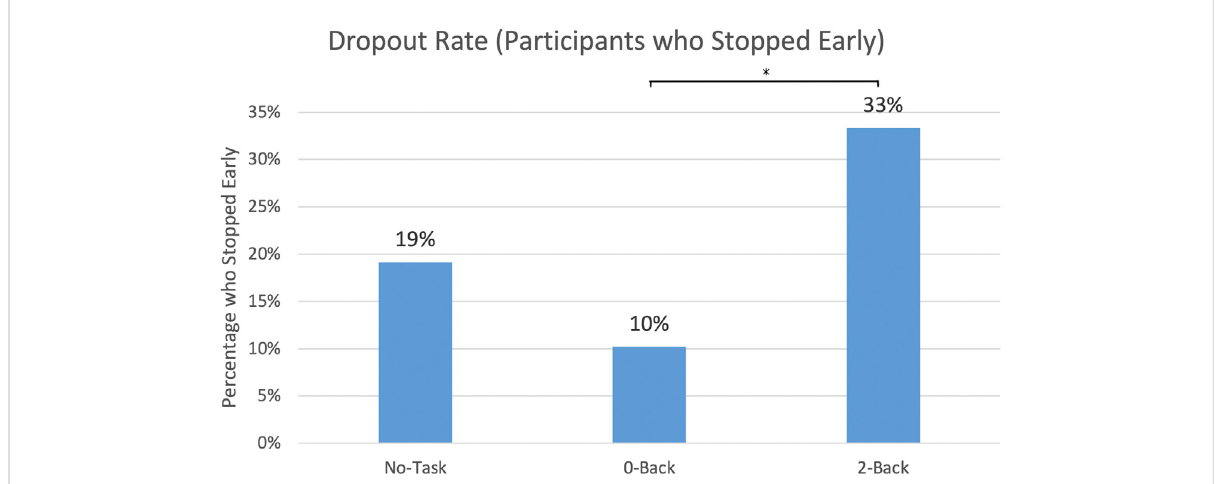
FIGURE 5 Dropout Rate by Group: the percent of participants who did not fi nish both laps of the Corn Maze. * = signi fi cant difference at a p < 0.05 level.